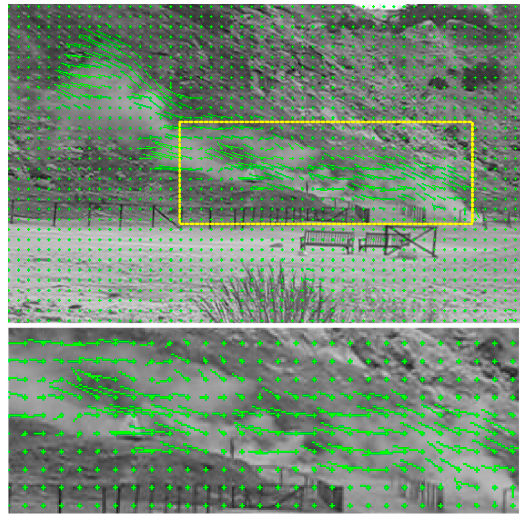
Figure 3. Cumulative optical flow field of three subsequent frames (1.5 s total duration) superposed onto the last frame for each 15th pixel (green+). The region of interest (ROI) as used for OF analysis is marked and a zoom of it is shown below. Some flow vectors in the upper left corner and center region indicate a non-laminar flow.